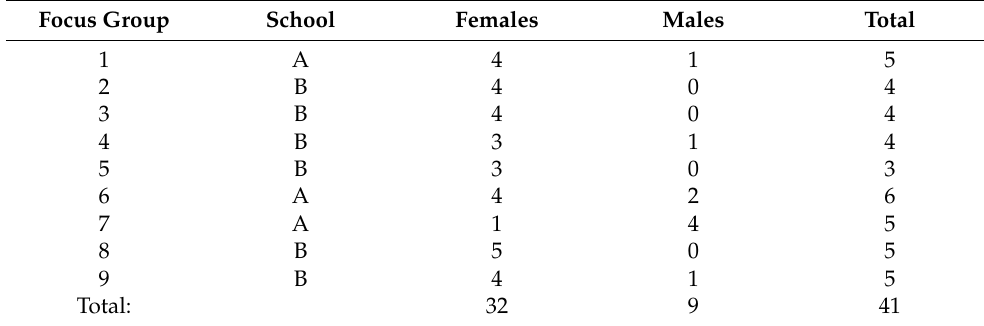
Table 1. Description of focus